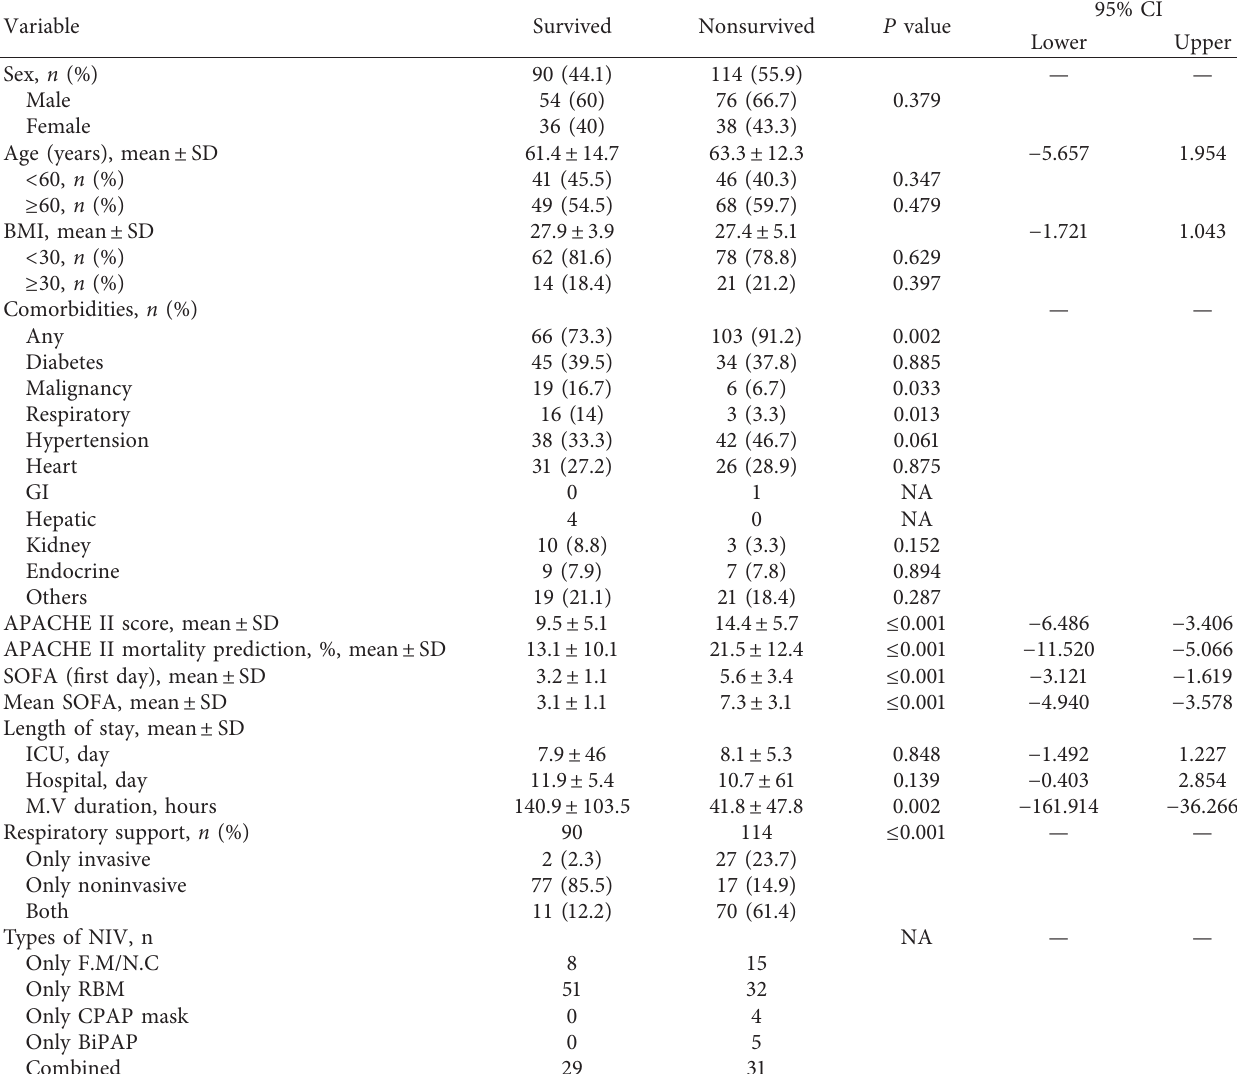
Table 1: Baseline characteristics of survived and nonsurvived